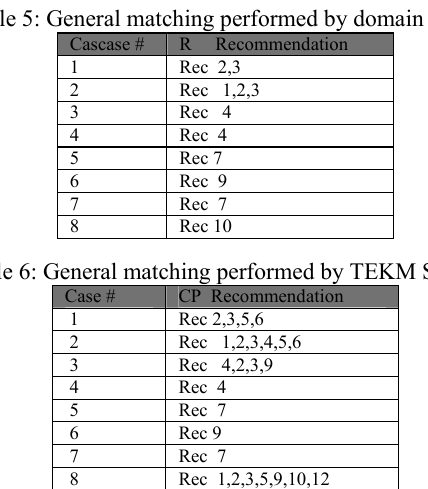
Figure 4: Recommendation 5 selected by user